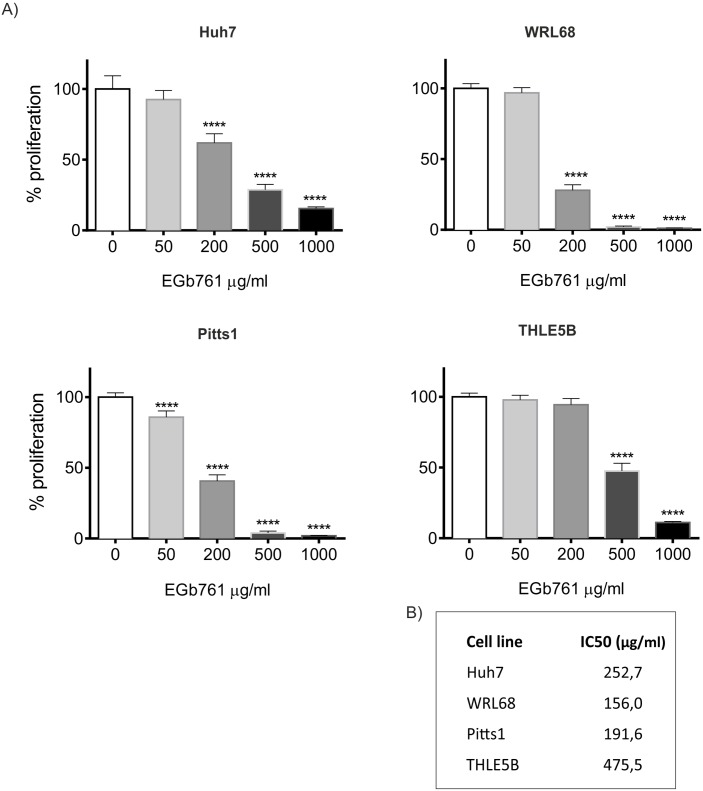
Dose-response of hepatoma cell lines and human hepatocytes to EGb761.(A) Cell proliferation after three-day exposure to indicated concentrations of EGb761 in hepatoma cells and IH using WST-1 assay. The data are means ±SD of four independent experiments, ****p<0.0001, analyzed by one-way ANOVA test for multiple group comparisons. (B) shows the corresponding IC50 values for each cell line.